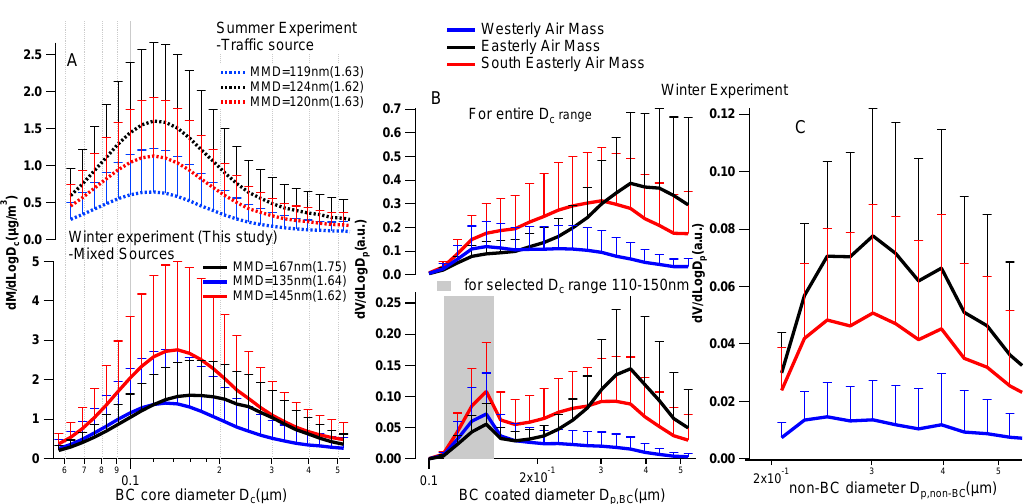
Figure 6. BC-related size distributions classified by air masses. The error bar are the + σ (standard deviation) and the value in brackets is the geometric standard deviation ( σ g ) for each size distribution: (a) BC core ( D c ) size distribution for both winter and summer experiments, with the dotted lines showing the summer experiment; the text boxes denote the mass median diameter, MMD, and the geometric mean σ g (in brackets) for each size distribution; (b) coated BC size ( D p ) distribution for the selected D c range, 110–150nm (with the grey shaded box showing the range of values) and for the entire detectable D c range in winter; (c) the size distribution of non-BC particles which do not contain BC core in